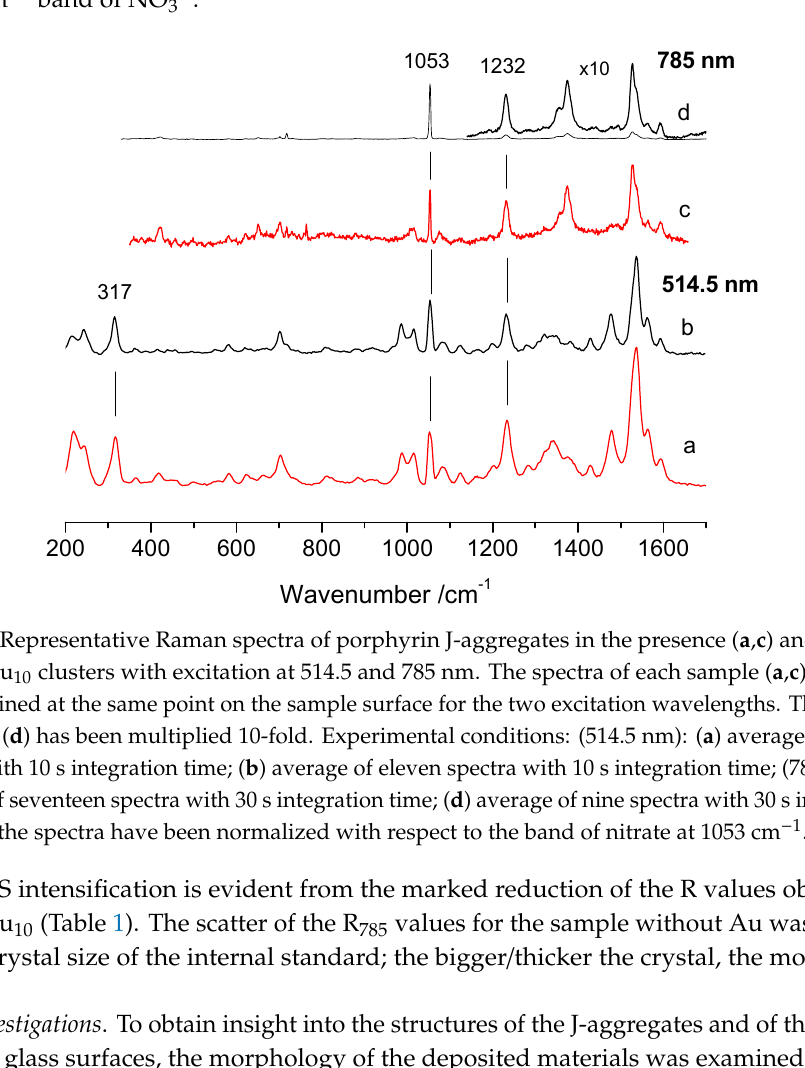
Table 1. Comparison of the intensity ratio (R) of the 1053 cm − 1 NO 3- band and the 317 and 1232 cm − 1 bands of the J-aggregates obtained with 785 and 514.5 nm excitation.